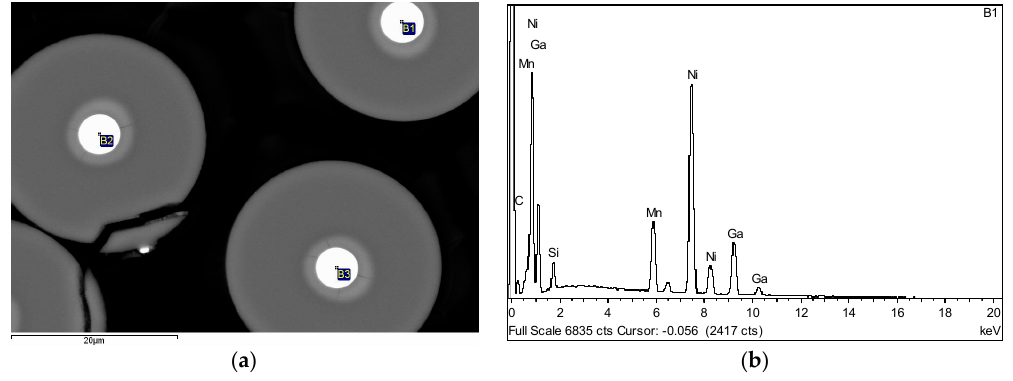
Figure 38. Images of the cross-section of the NiMnGa microwires ( a ) and EDX spectra of one of the points where the chemical composition has been determined ( b ). Reproduced from reference [117], Figure 1.